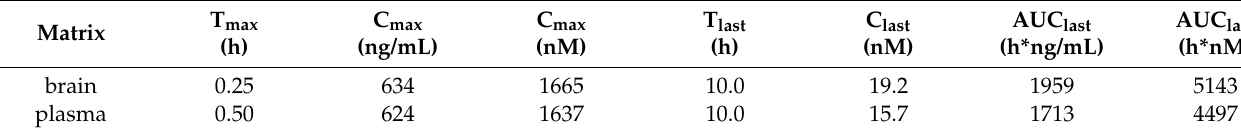
Table 1. Pharmacokinetic parameters of ( S )-MK-26 upon i.p. administration with dose of 10 mg/kg of body weight.